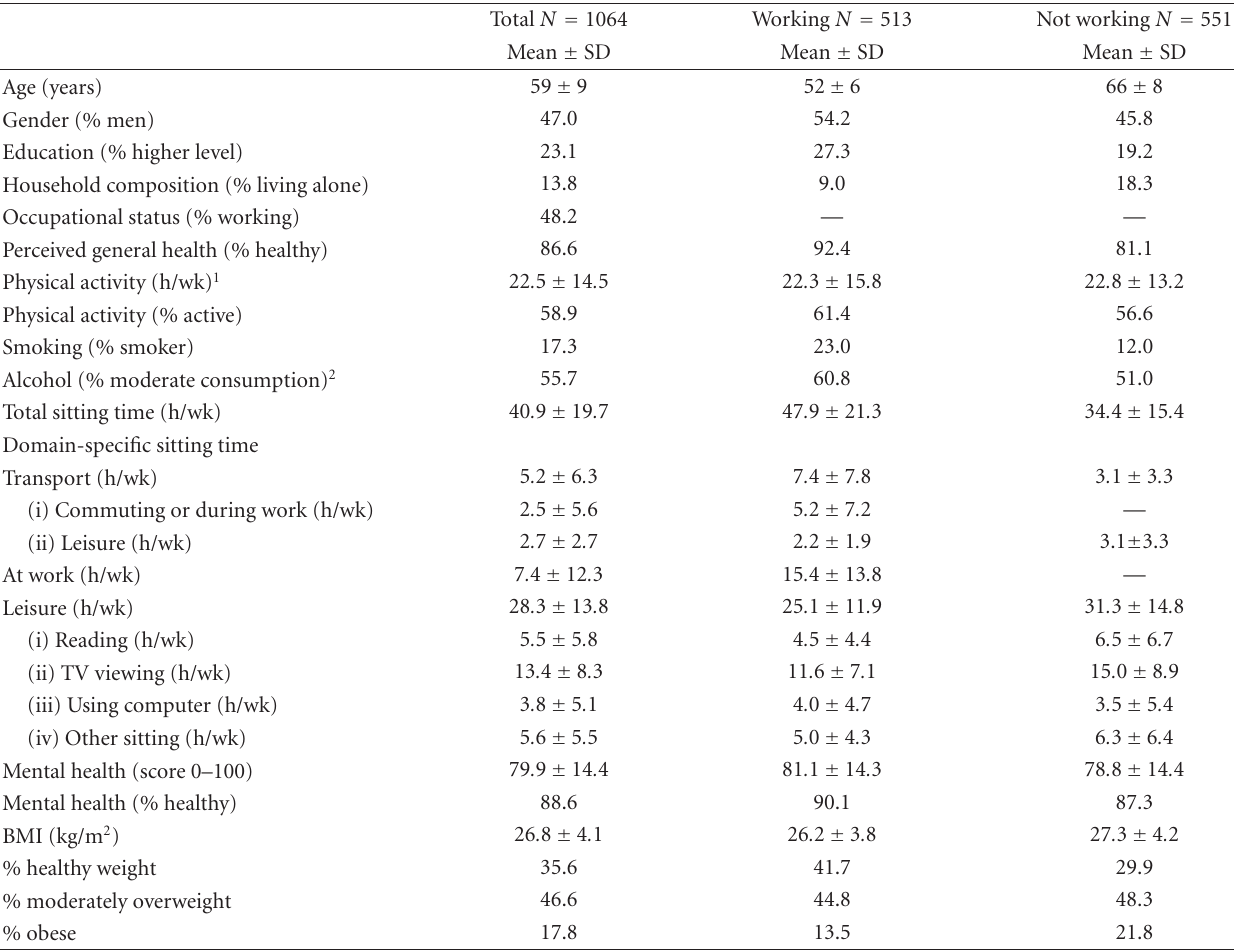
Table 1: Characteristics of the study population ( n =